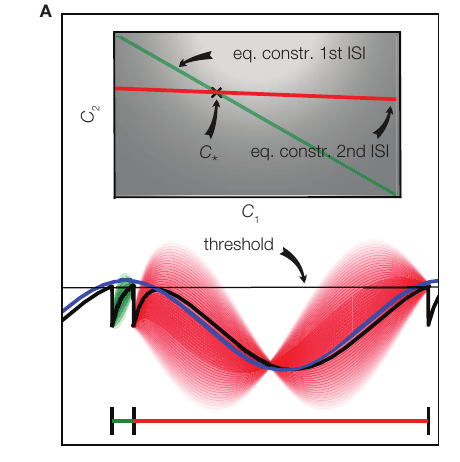
an exponential filter (first box). Whenever the resulting integrated signal (second box) reaches a predefined threshold the integration is reset (third box). Alternatively, one can apply the filtering, integrating and resetting at the given spike times to each basis function separately, and then do a weighted summation of these signals. Both constructions lead to the same membrane potential, and thus the same spike trains.